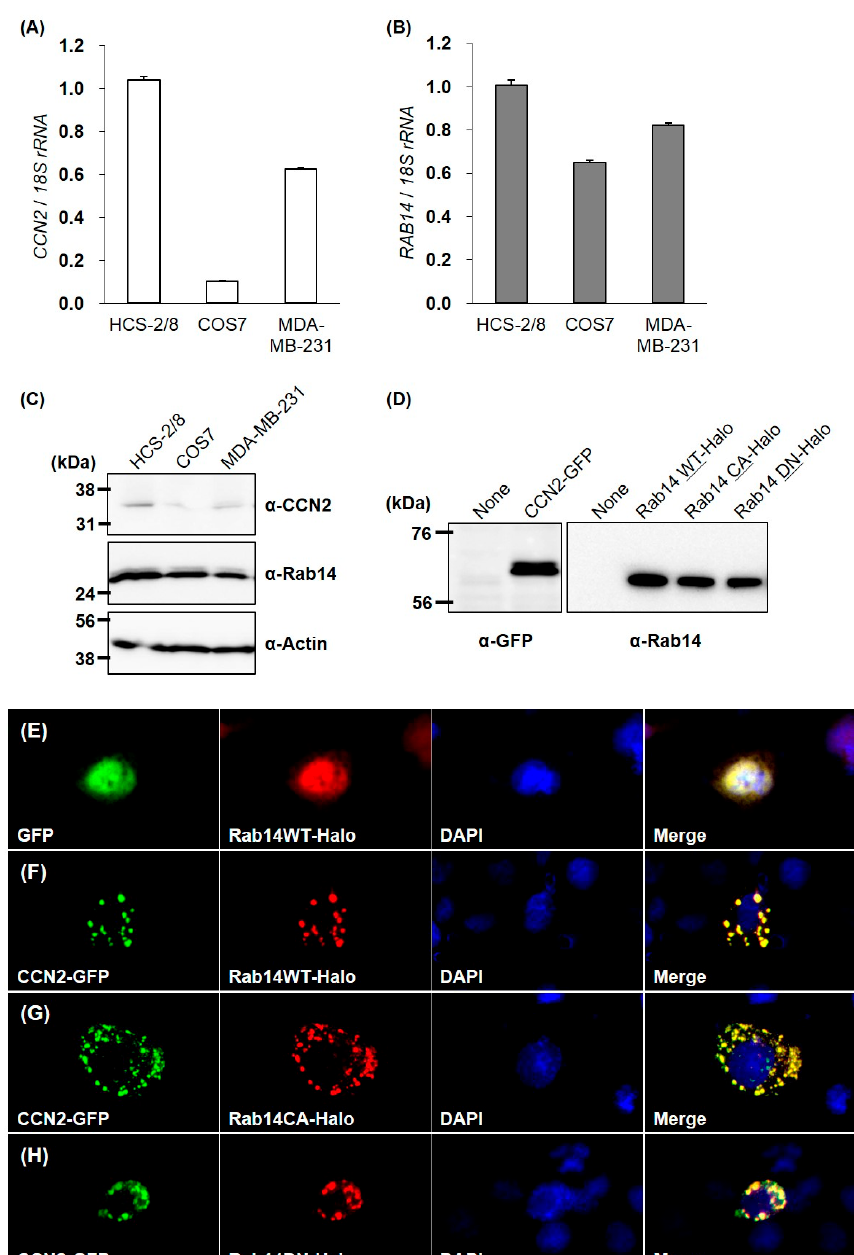
Figure 3. CCN2 and Rab14 expression in HCS-2/8, COS7, and MDA-MB-231 cell lines, and molecular imaging of CCN2 and Rab14 ectopically overexpressed in COS7 cells. The expression level of CCN2 and Rab14 in the cell lines was analyzed by qRT-PCR and Western Blotting ( A – C ). All cells were incubated under standard culture conditions (20% O 2 , 5% CO 2 , and 37 °C). The expression of GFP-fused CCN2, Halo-fused Rab14WT, Rab14 CA and Rab14DN proteins in the COS7 cell were confirmed by Western blotting ( D ). COS7 cells were cotransfected with GFP-fused CCN2 and Halo-fused Rab14WT or Rab14 mutants. GFP-fused proteins (green) and Halo-fused proteins (red) were overexpressed together and directly monitored by fluorescence microscopy. The counterstaining of nuclei was performed with DAPI (blue), and these images were merged using a software program. Without CCN2-coexpression, Halo-tag or Rab14WT showed cytosolic distribution ( E ). Halo-tagged Rab14WT was overexpressed with GFP-fused CCN2 ( F ). Rab14CA was overexpressed with CCN2 ( G ), and Rab14DN was overexpressed with CCN2 ( H ). Similar results were obtained in different examinations. Scale bar: 20 µm.